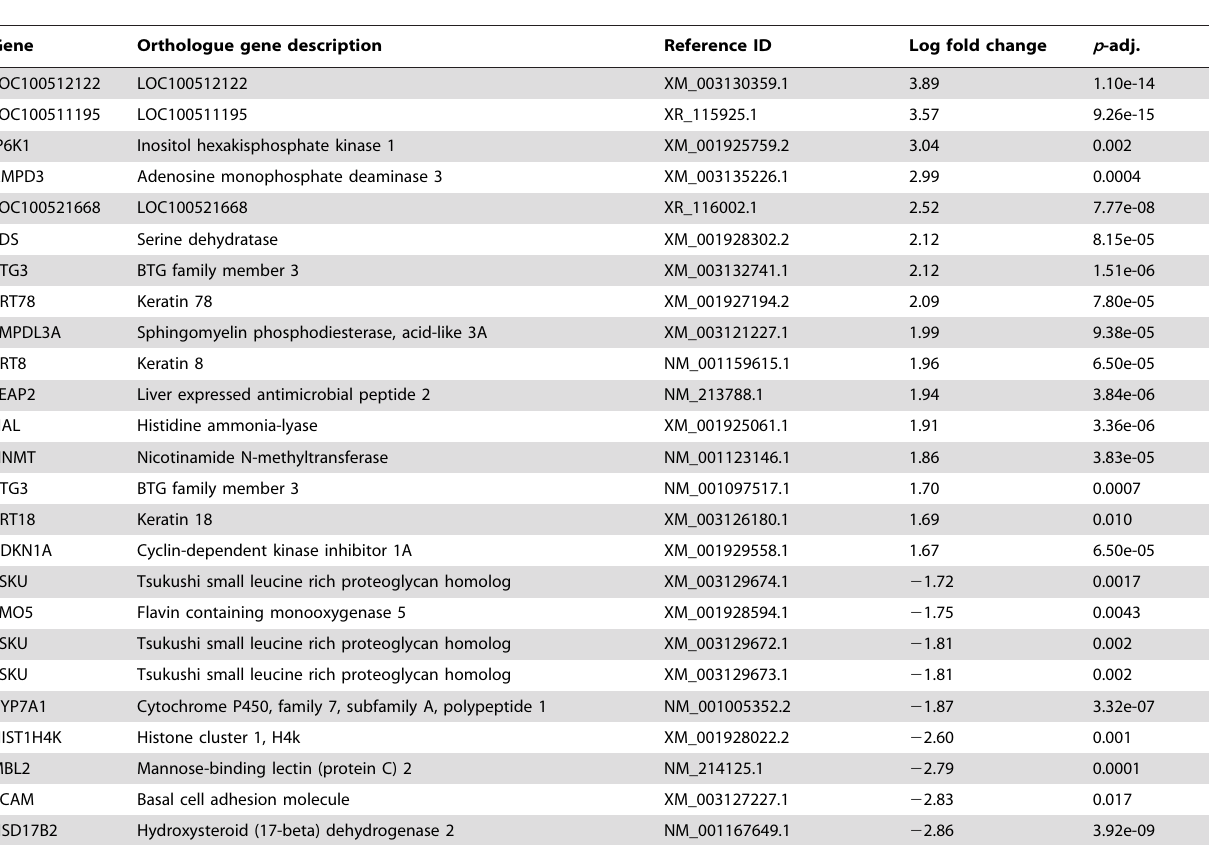
Table 4. Differentially expressed genes in liver androstenone samples.